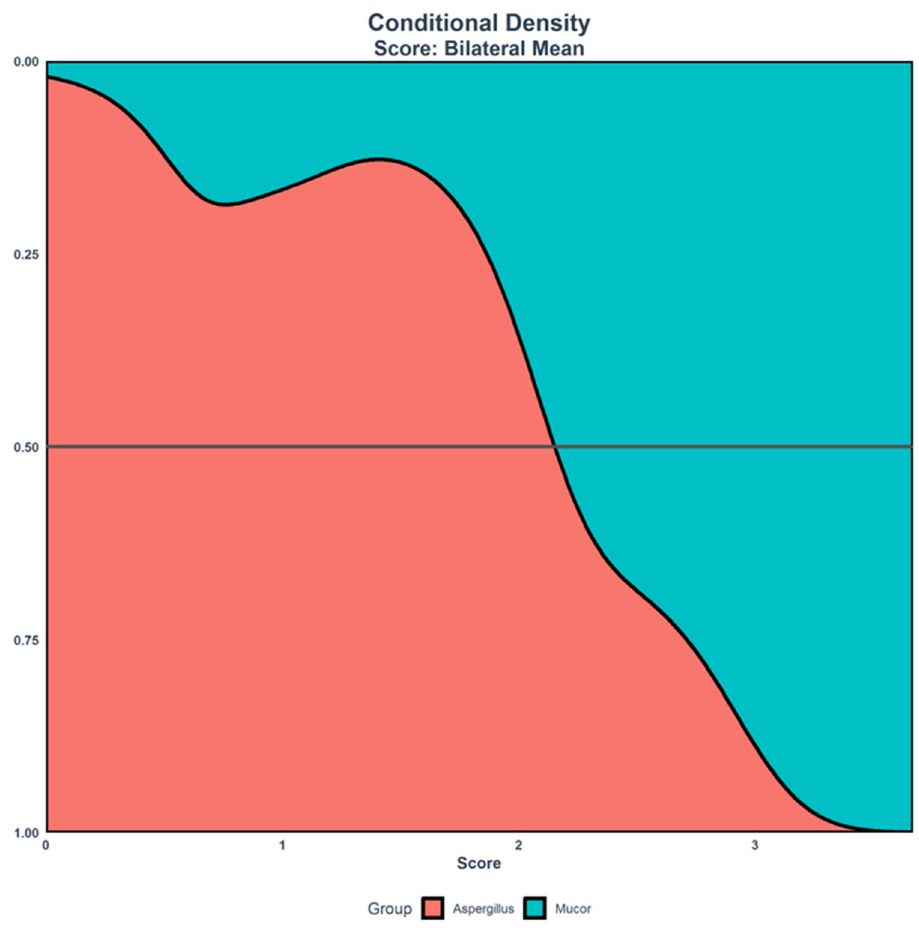
Figure 3. Conditional density diagram of the bilateral mean model. Patients with AIFR caused by Mucor species had higher mean score values compared with patients with AIFR caused by Aspergillus